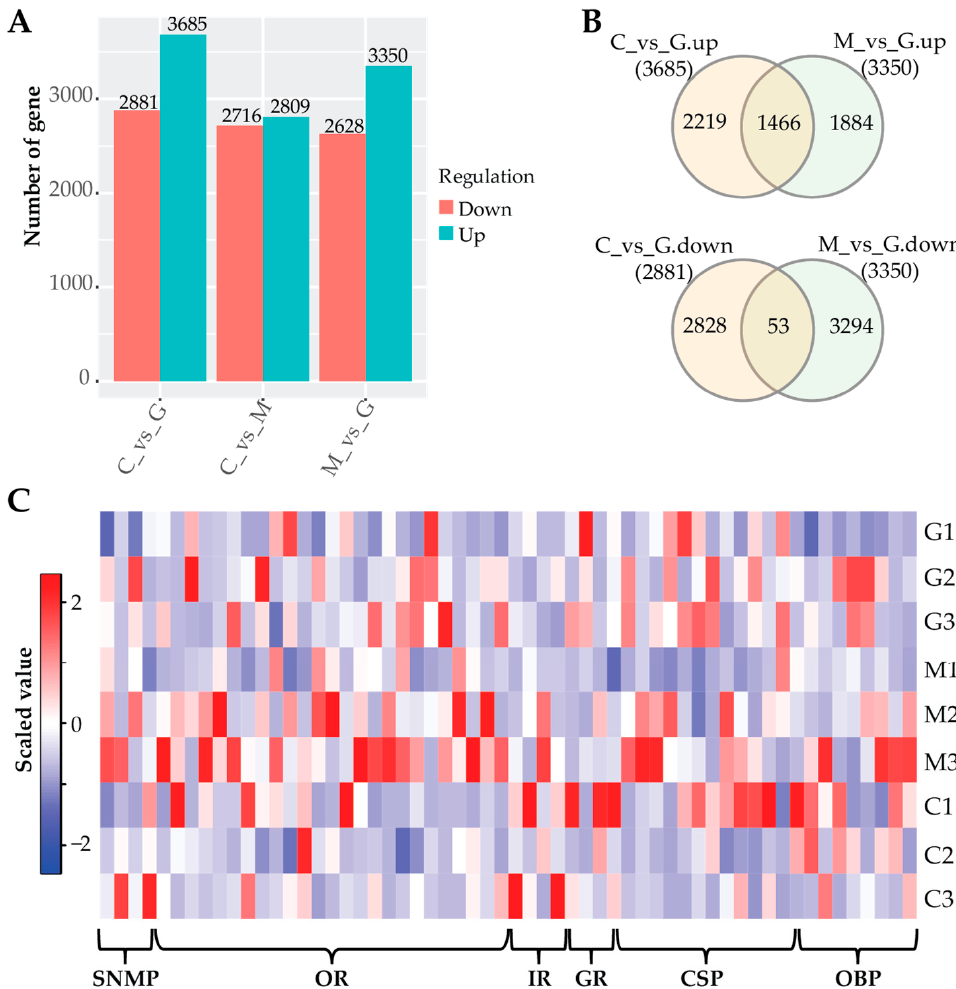
Figure 4. Differentially expressed transcripts in the parasitoid wasps of fruit flies fed with different fruits. ( A ) Number of differentially expressed transcripts in the insects in response to two fruit scents. ( B ) Venn diagram of up- (upper panel) and downregulated (lower panel) transcripts identified in C and M, compared to G. ( C ) A heat map showed the differential expression of 9 OBPs, 13 CSPs, 3 GRs, 4IRs, 25 ORs, and 4 SNMPs in the parasitoid wasps of fruit flies fed with different fruits.